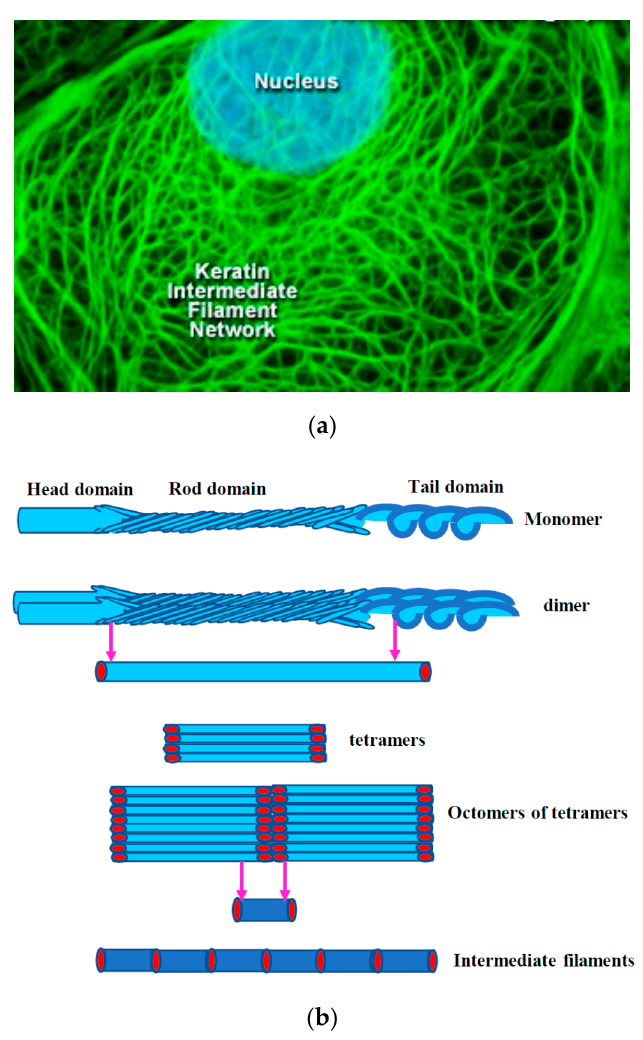
Figure 6. Structure of intermediate filaments. ( a ) Keratin intermediate network found in a rat kangaroo (PtK2 line) epithelial cell as seen through a fluorescence optical microscope (image reproduced with permission from MolecularExpressions.com at Florida State University Research Foundation). ( b ) Graphical representation of the structure of intermediate filaments.